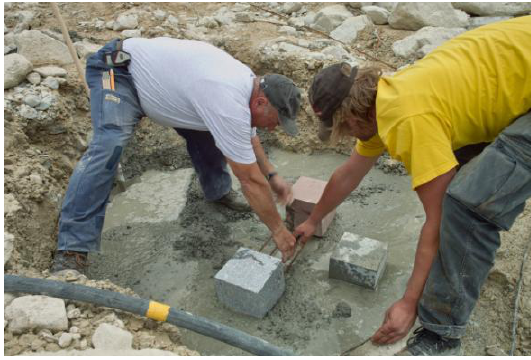
Figure 1. Installation of rock samples at the Illgraben